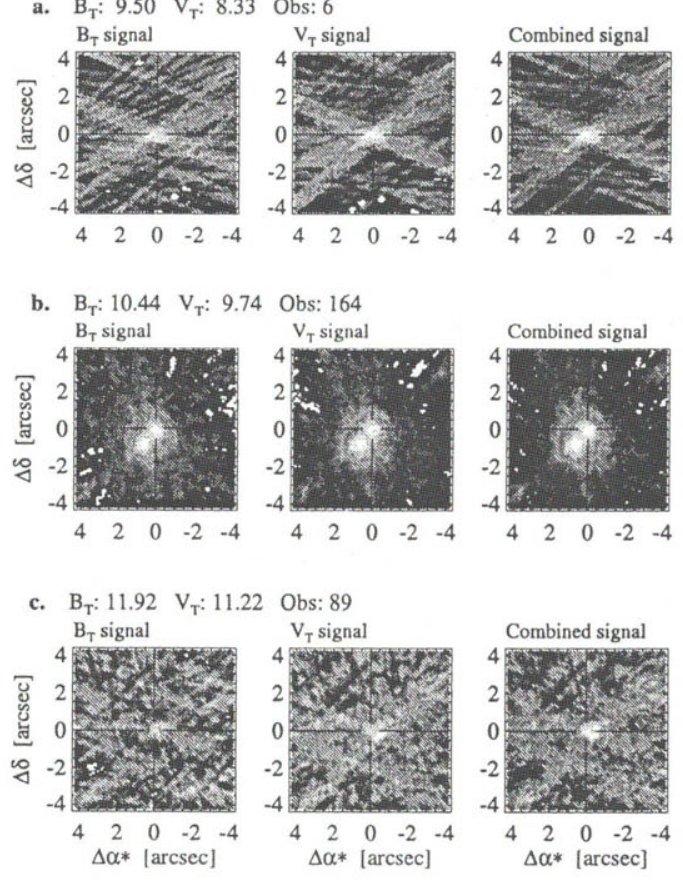
Fig. 8. A flux map from the second Tycho data reduction. Superpo- sition of photons in maps of 8x8 as 2 , centered on the predicted position. In case of Tycho-2 , the effects of known parallax and proper motion are included in the predicted positions. An offset from the center thus deter- mines a correction to the position given in the Tycho-2 input catalogue, (a) Only six observations were included in order to show the principle, therefore only a few position angles of the slit appear, (b) A double star with 1.2 as separation and clearly resolved in 164 observations, although the observed slit response function has FWHM = 1.0 as. (c) A faint star, very faint in the 5τ signal, but clearly detectable in Vt and the combined